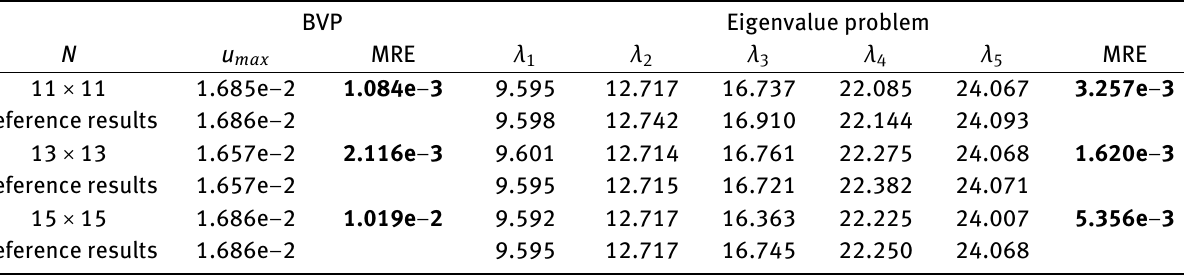
Table 2: The results from solving the biharmonic problems on the quarter section of the elliptical domain. The boundary conditions given by Eq. (28) implemented using strategy 2.